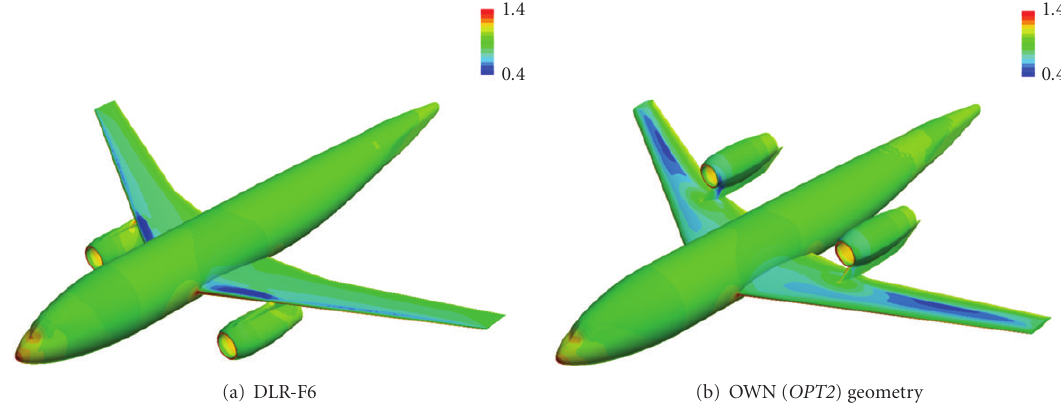
Figure 21: Comparison of surface pressure coe ffi cient